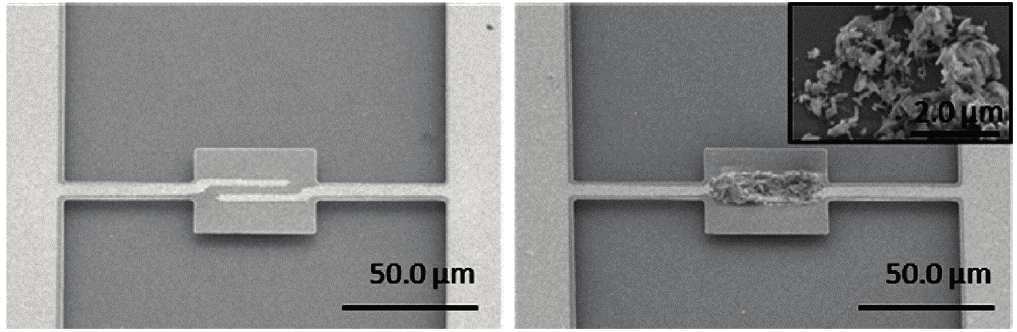
Figure 18. SEM images of the fabricated resonator ( left side : without the ZIFs; right side : with the ZIFs. Reprinted with permission from [97].